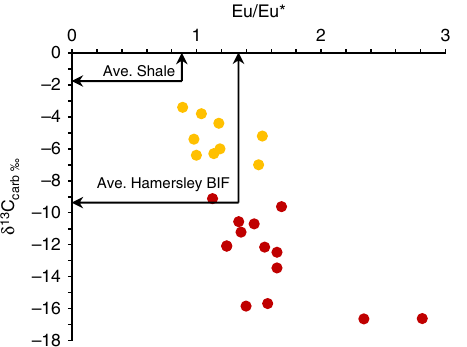
Fig. 7 Correlation between hydrothermal input and δ 13 C carb in BIF. Note increasing hydrothermal input corresponds to increasing depletions in δ 13 C 18 , and red points from Smith carb . Yellow points are from Teixeira et al. et al. 17 . BIF from Teixeira et al. 18 are carbonate-magnetite-quartz BIF; BIF from Smith et al. 17 are laminated magnetite-siderite chert-banded iron formation or laminated ferhythmite. Average Paleoproterozoic shale and BIF values after Alibert and McCollom